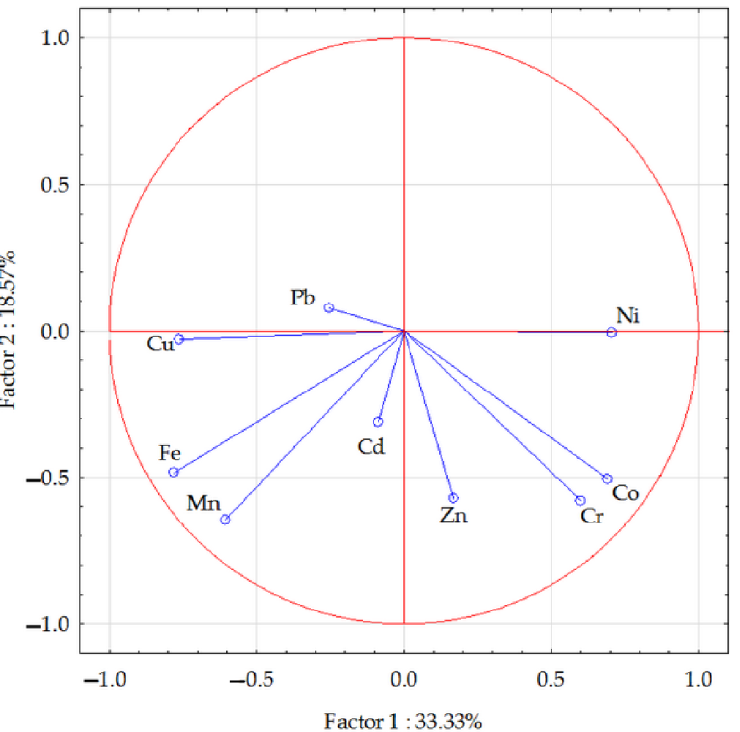
Figure 1. The content of trace elements in the soil illustrated with a PCA analysis. Key: vectors represent analysed variables (content of Cd, Pb, Cr, Ni, Zn, Cu, Mn, Fe, and Co).